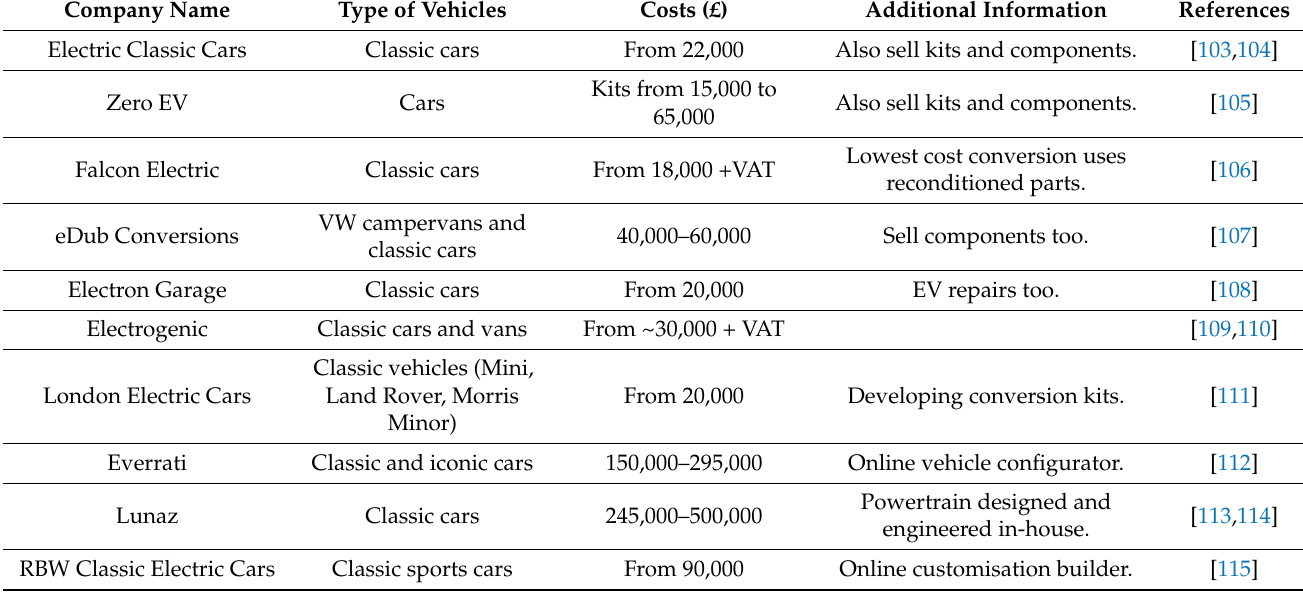
Table 4. Table highlighting a range of current retrofit companies. (N.B: Some prices were sourced from press articles as they were not supplied on the company